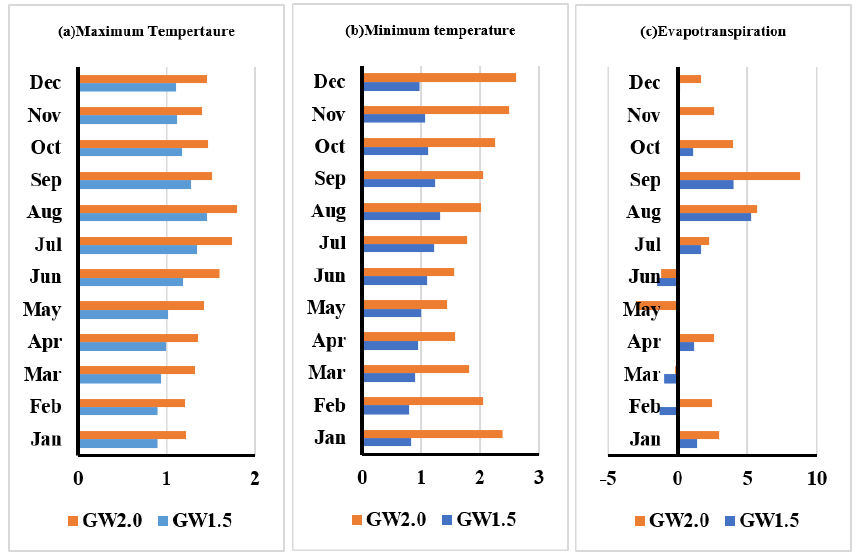
Figure 5. The monthly deviations of the climate variables under current GW1.5 and GW2.0 situations.